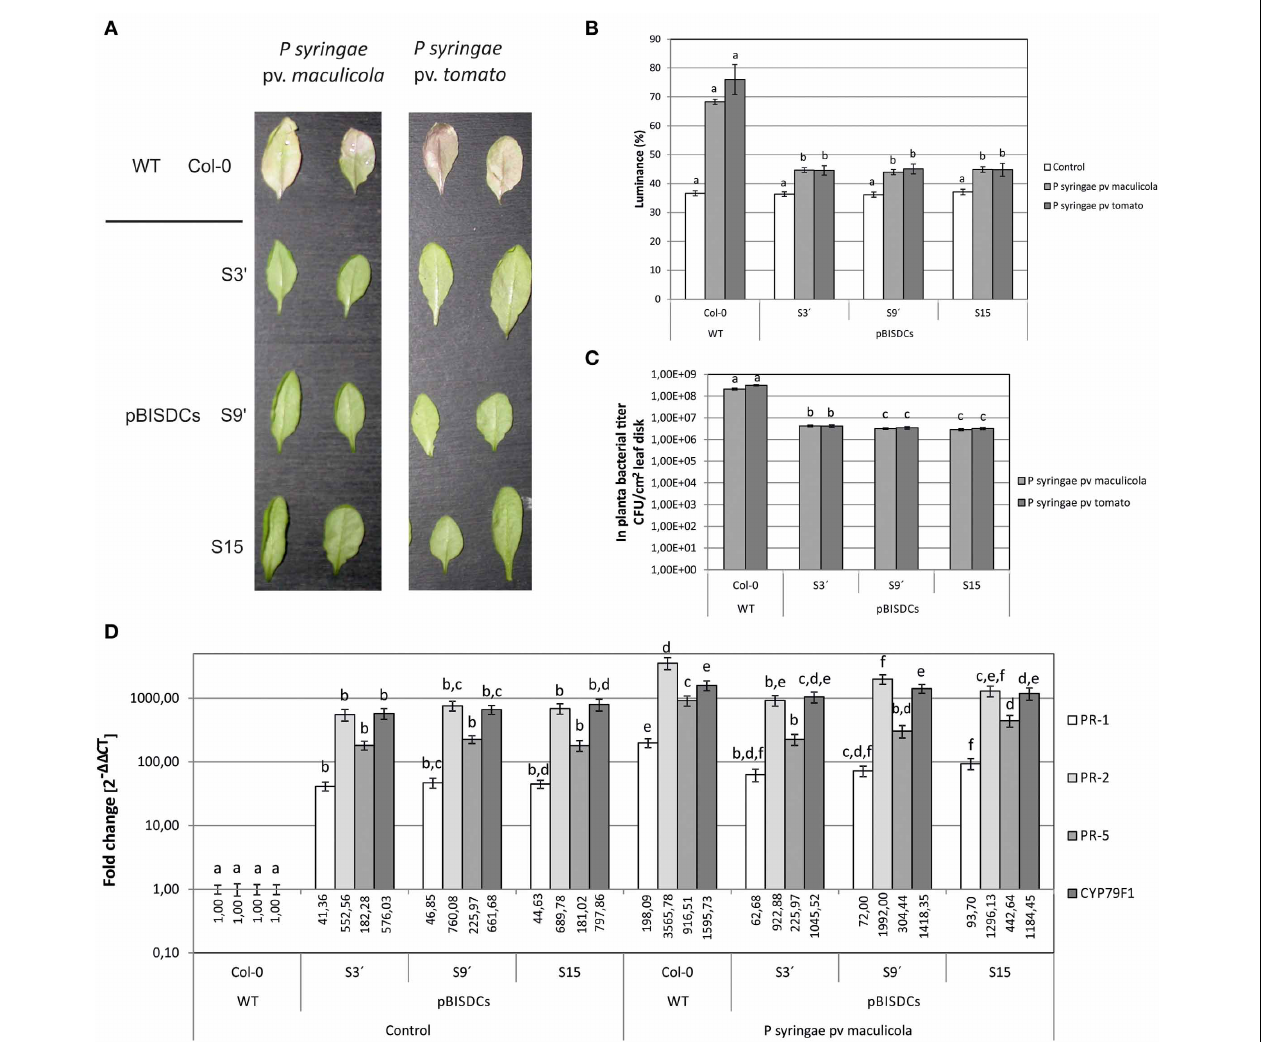
combination of line and bacterial strain. For each condition, significant differences between lines are indicated with letters [ANOVA, Tukey HSD test (luminance data) or Dunnet’s T3 test (CFU data), p < 0 . 05]. Plant response to P. syringae pv. maculicola infection was also studied by comparison of the expression levels for a set of biotic stress defense-related genes 3 days after inoculation with the bacterial strain or control inoculums (D) . For each gene, data is expressed as fold change relative to the level measured in WT plants inoculated with control inoculum (2 − (cid:2)(cid:2) CT ). Graph show the mean of three biological replicates ± standard deviation. Significant differences between plant lines are indicated with letters (ANOVA, Tukey HSD test, p < 0 .